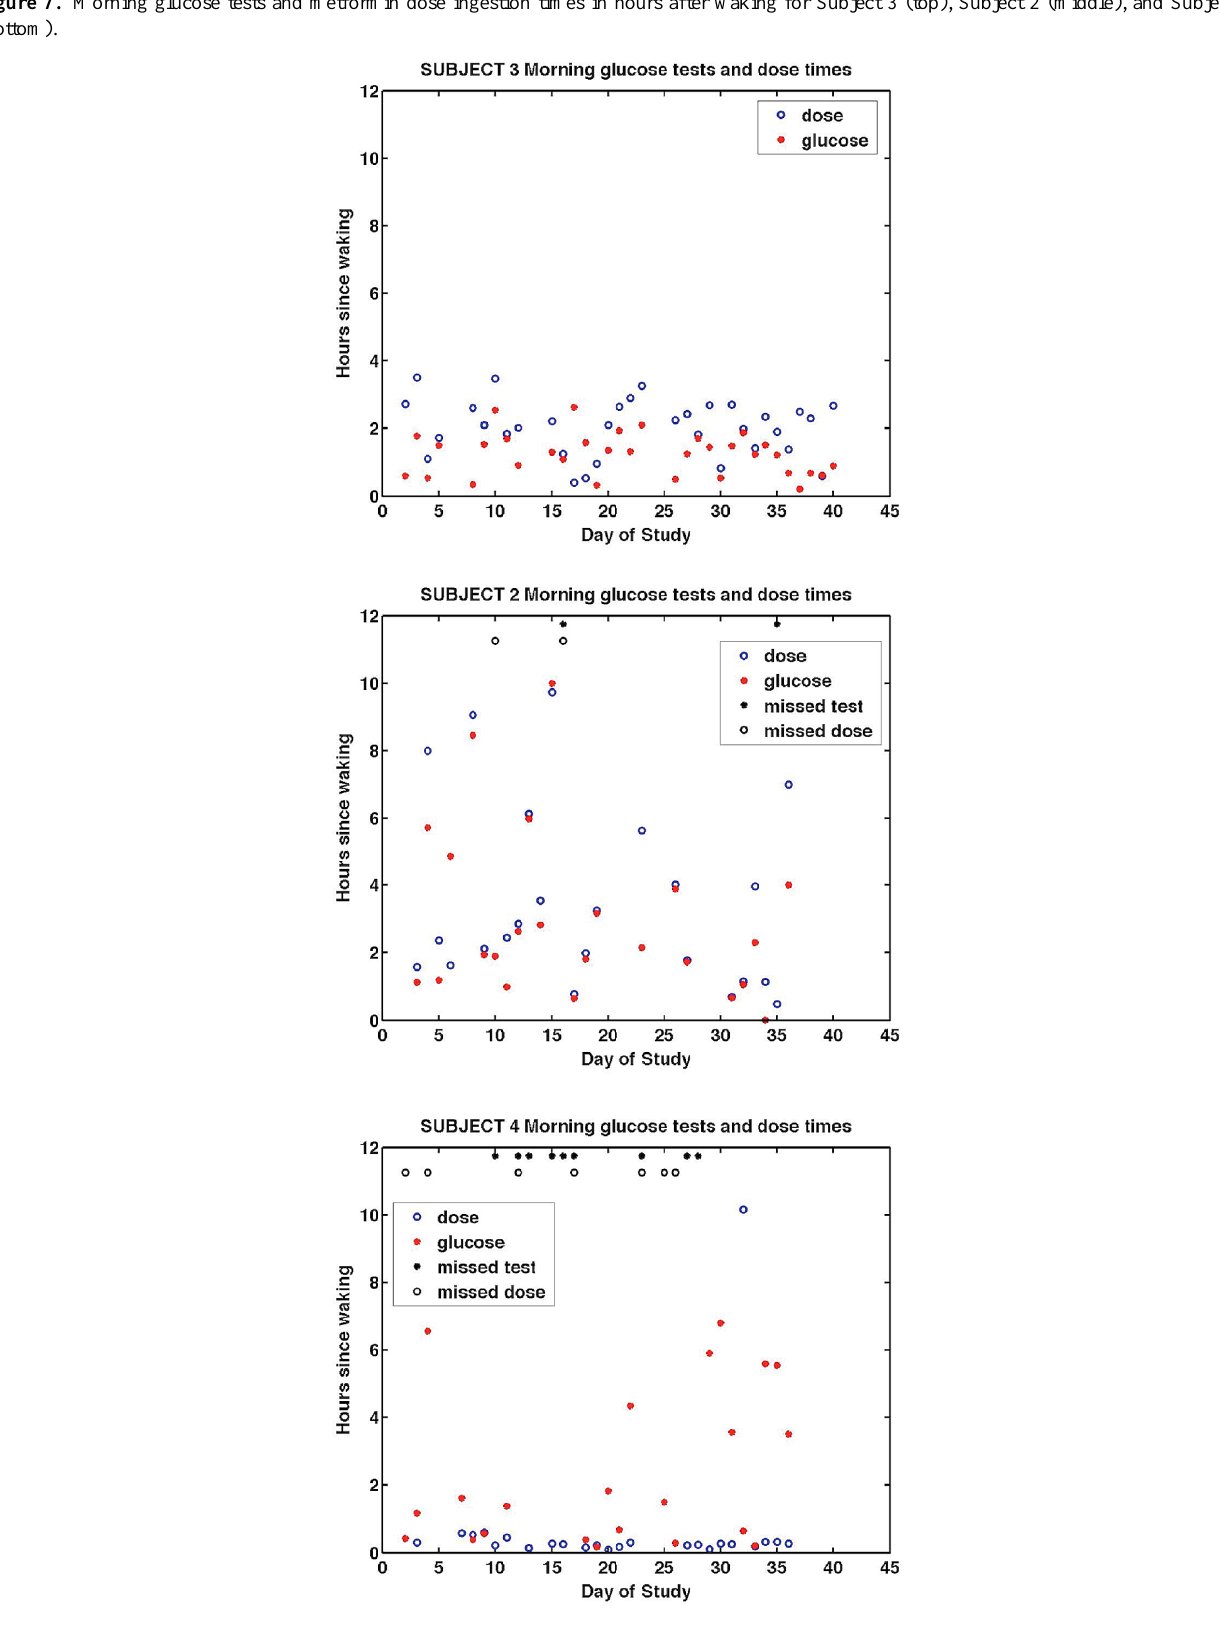
Figure 7. Morning glucose tests and metformin dose ingestion times in hours after waking for Subject 3 (top), Subject 2 (middle), and Subject 4